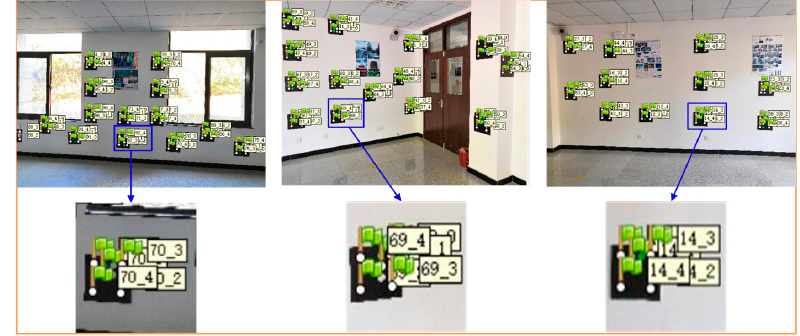
Figure 8. Identified color encoded targets.